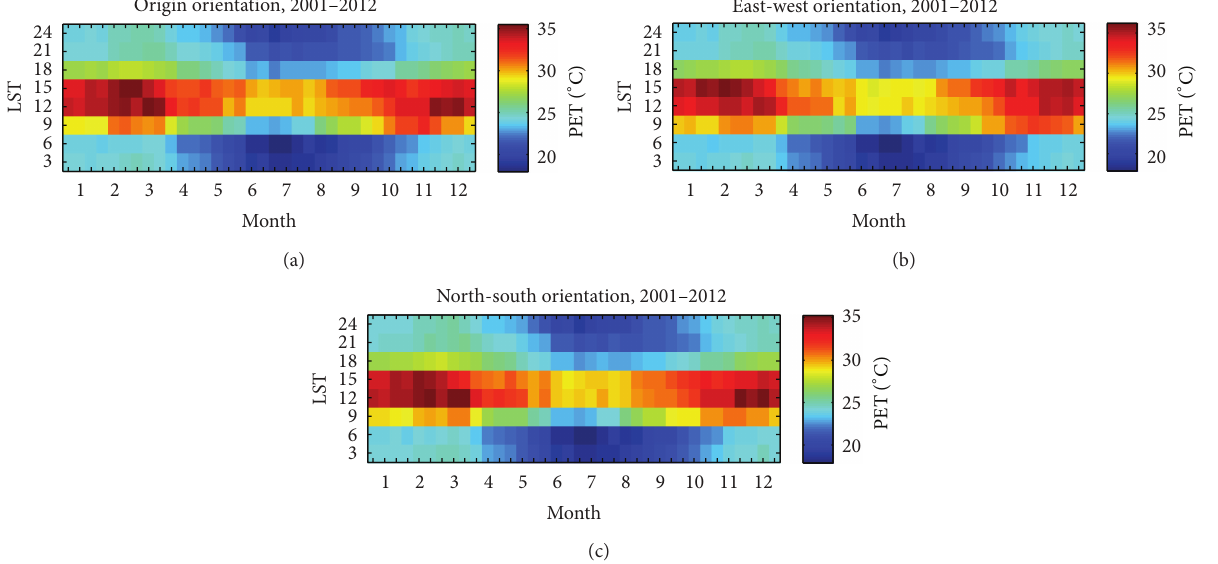
Figure 5: The temporal distribution of thermal comfort conditions in terms of PET index at the urban street in its origin orientation of a northwest-southeast direction (a), east-west orientation (225 ∘ ) (b), and north-south orientation (315 ∘ ) (c), suggesting a high prevalence of human thermal stress between 12 and 15 LST particularly from late October to early